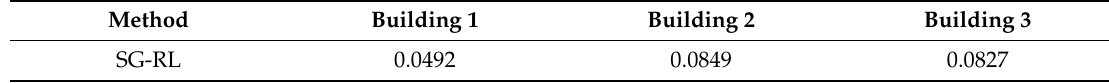
Table 3. Action-switching frequency of SG-RL.